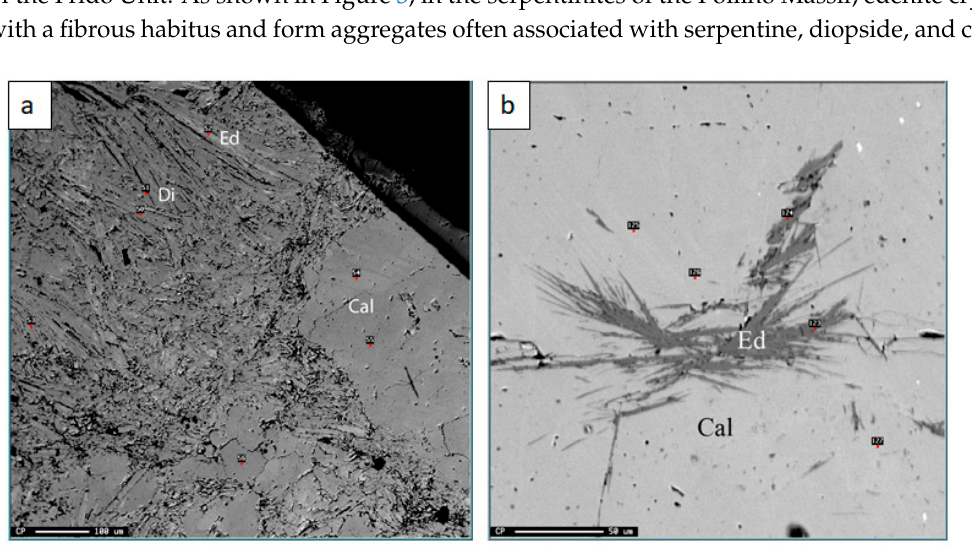
Figure 3. Secondary-electron image of serpentinite of the Pollino Massif showing ( a ) edenite, diopside, and calcite; ( b ) edenite crystals with both fibrous habit.